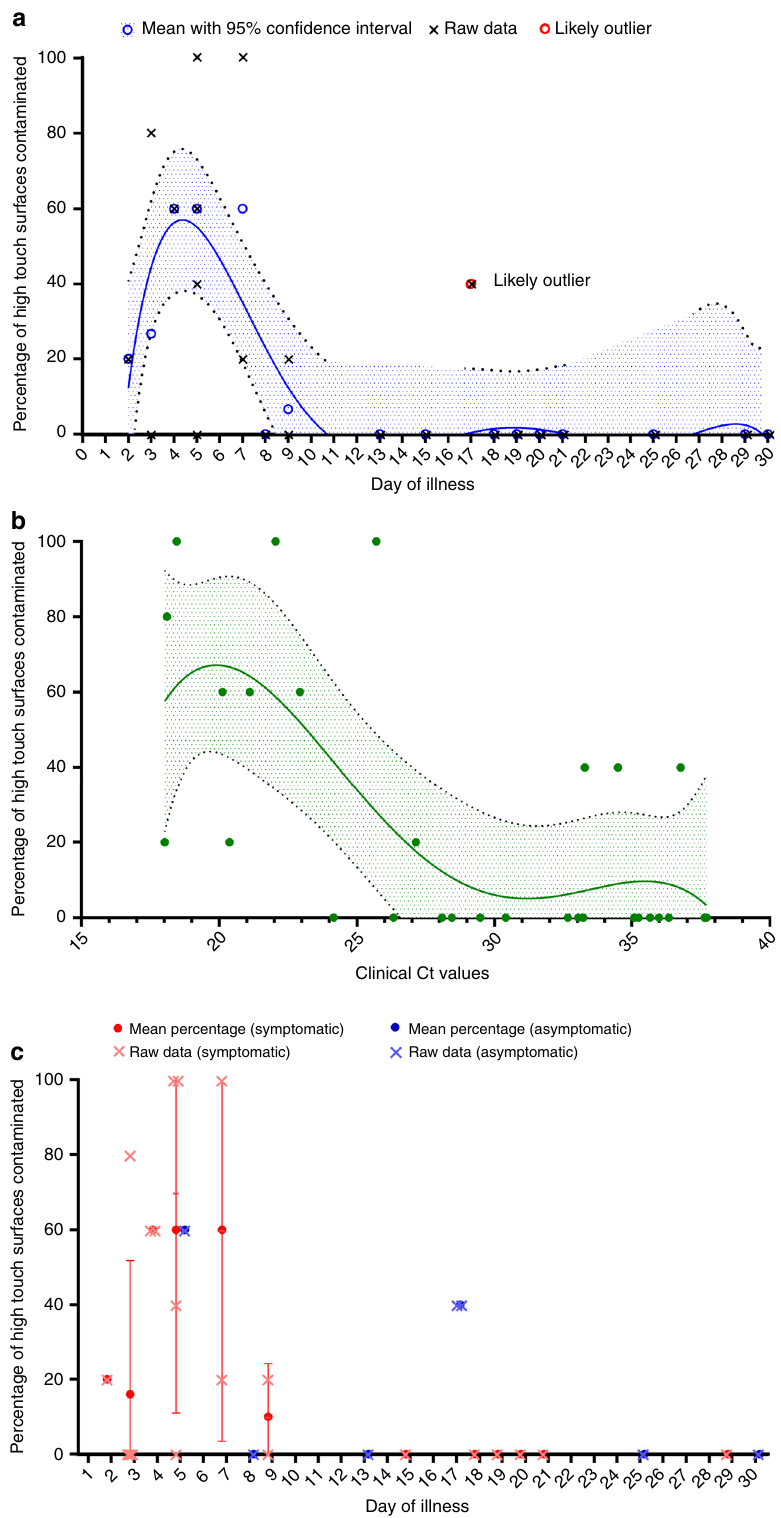
Fig. 3 Patient and disease factors affecting percentage of high-touch contamination. a Mean percentage of high-touch surface contaminated by day of illness with 95% con fi dence interval with best fi t curve, n = 30. b Percentage of high-touch surfaces contaminated by clinical cycle threshold values with 95% con fi dence interval with best fi t curve, n = 30. c Mean percentage of high-touch surface contaminated by day of illness with 95% con fi dence interval grouped by symptoms, n =